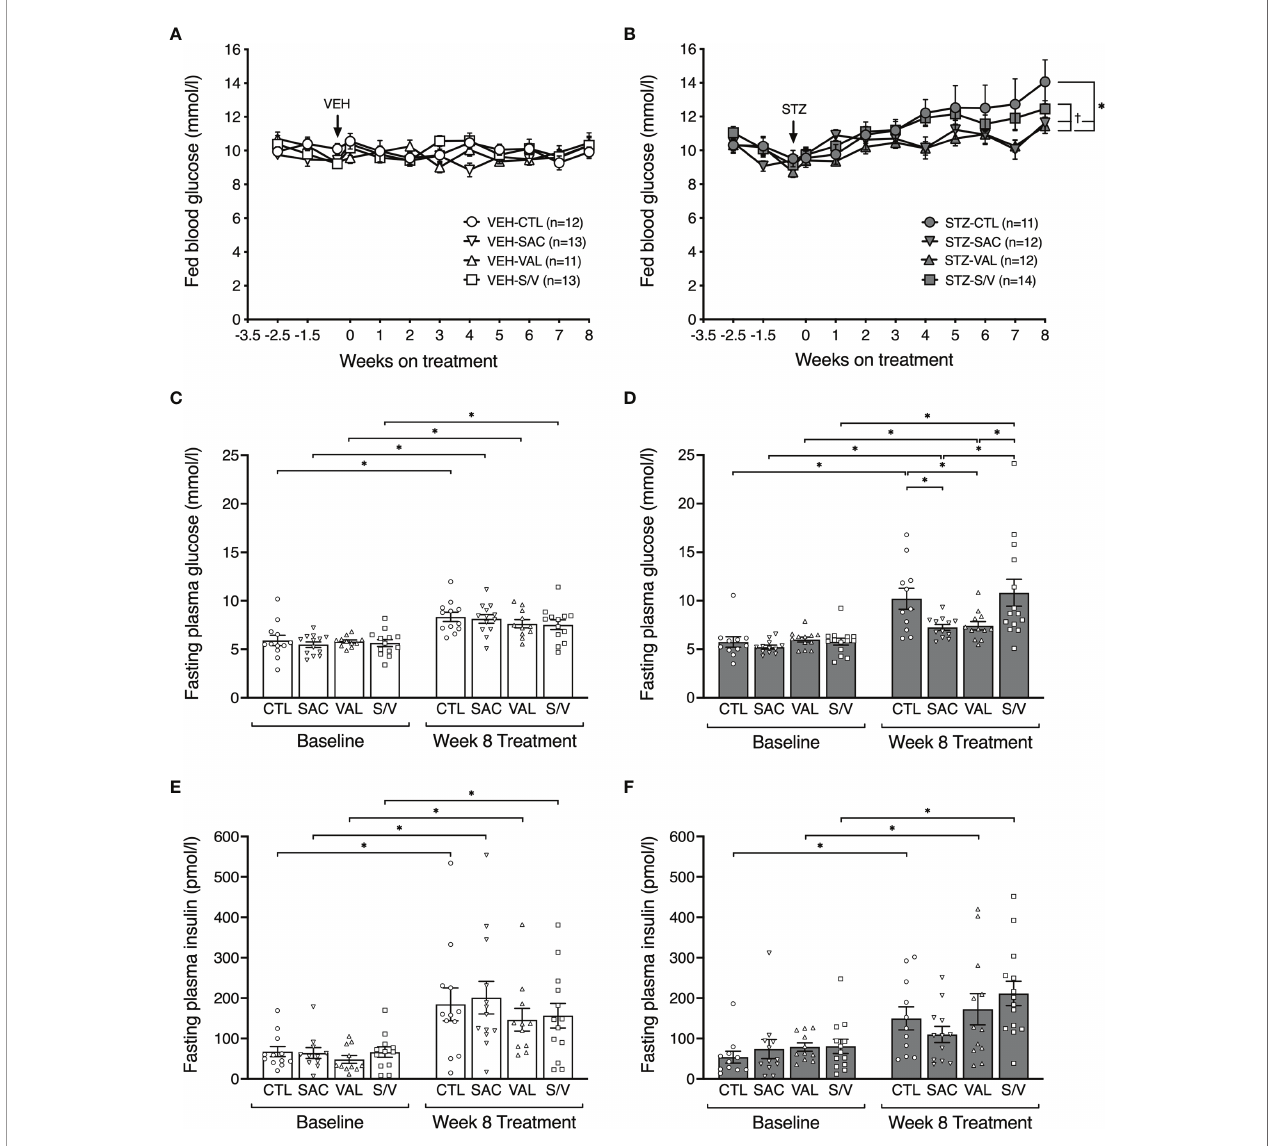
FIGURE 2 | Sacubitril and valsartan but not sacubitril/valsartan lower fed and fasting glucose in diabetic mice. Fed blood glucose levels over time in vehicle ( A ;VEH) and streptozotocin ( B ; STZ)- injected high fat-fed mice treated for 8 weeks with control (circles, CTL), sacubitril (inverted triangles, SAC), valsartan (triangles, VAL) or sacubitril/valsartan (squares, S/V). The arrow shows when VEH or STZ was injected. n=11-14/group. *p<0.05 SAC and VAL vs CTL, † p<0.05 SAC and VAL vs S/V. 16-hour fasted plasma glucose (C, D) and insulin (E, F) measured in VEH (C, E) and STZ (D, F) groups of mice at baseline (week -3.5) and at the end of the 8-week treatment period with CTL, SAC, VAL or S/V. n=11-14/group.